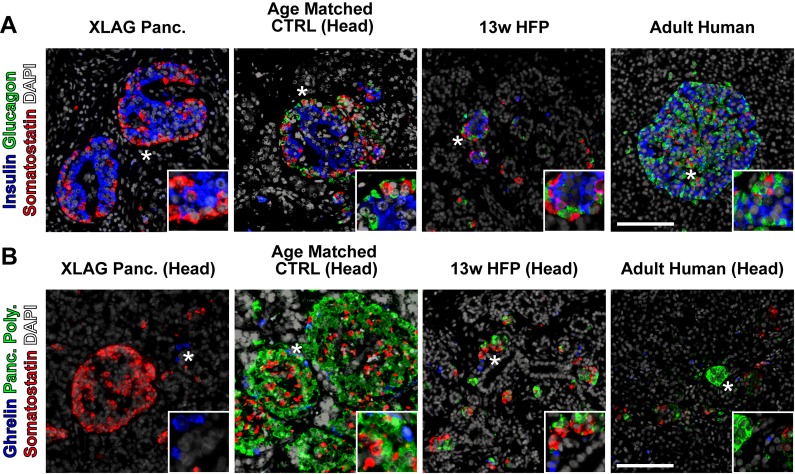
XLAG Pancreatic Endocrine Profile.16-month old XLAG (ARX knockout) pancreatic tissue, age-matched control pancreatic tissue, 13w human fetal pancreatic tissue, and adult human pancreatic tissue were immunostained for insulin (blue), glucagon (green), somatostatin (red) and DAPI (white) in (A) and ghrelin (blue), pancreatic polypeptide (green), somatostatin (red) and DAPI (white) in (B). "Head" indicates specific sample from head region of the pancreas. Inset is a ~3x enlarged portion from the region indicated by the star. Scale bar is 100 μm for all panels.